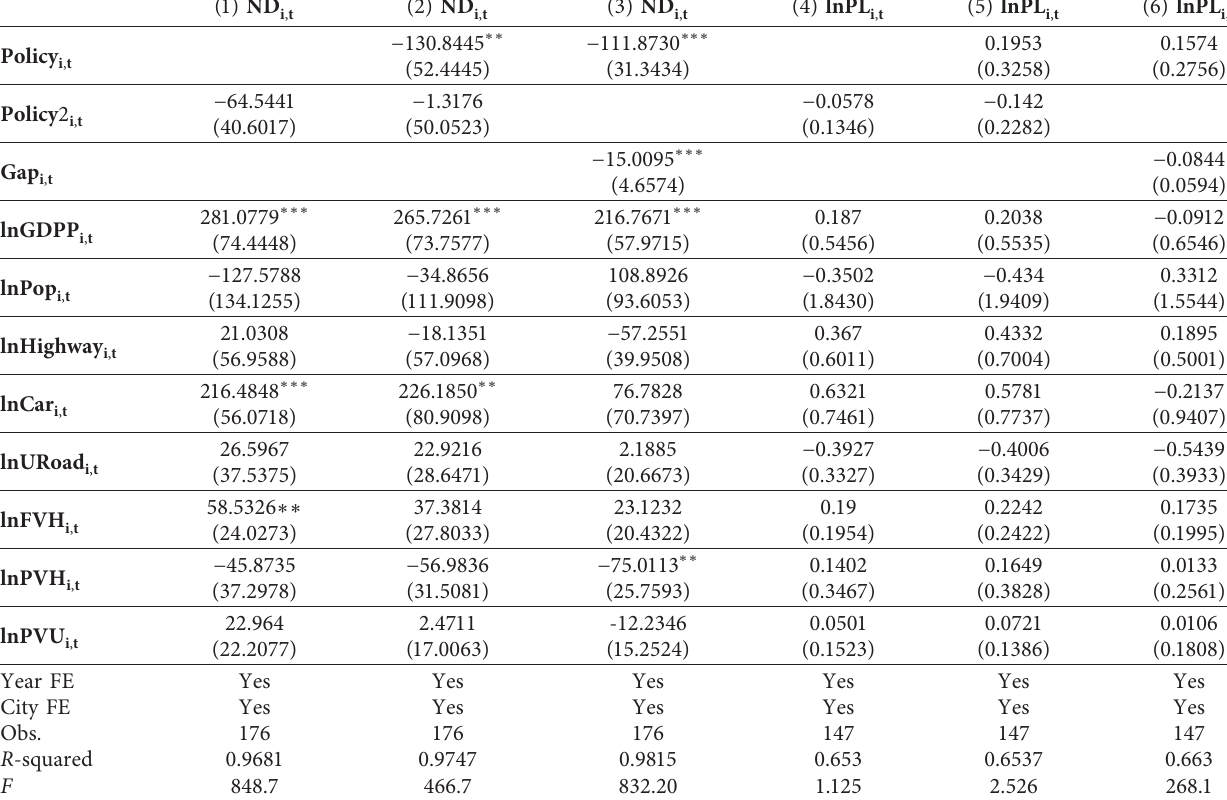
Table 6: The effect of renewal years and implementation years on traffic